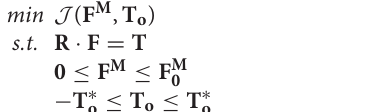
TABLE 1 | Classification of the muscles used in this work according to the joint (hip, knee, or ankle) and movement (flexion, extension) provided.